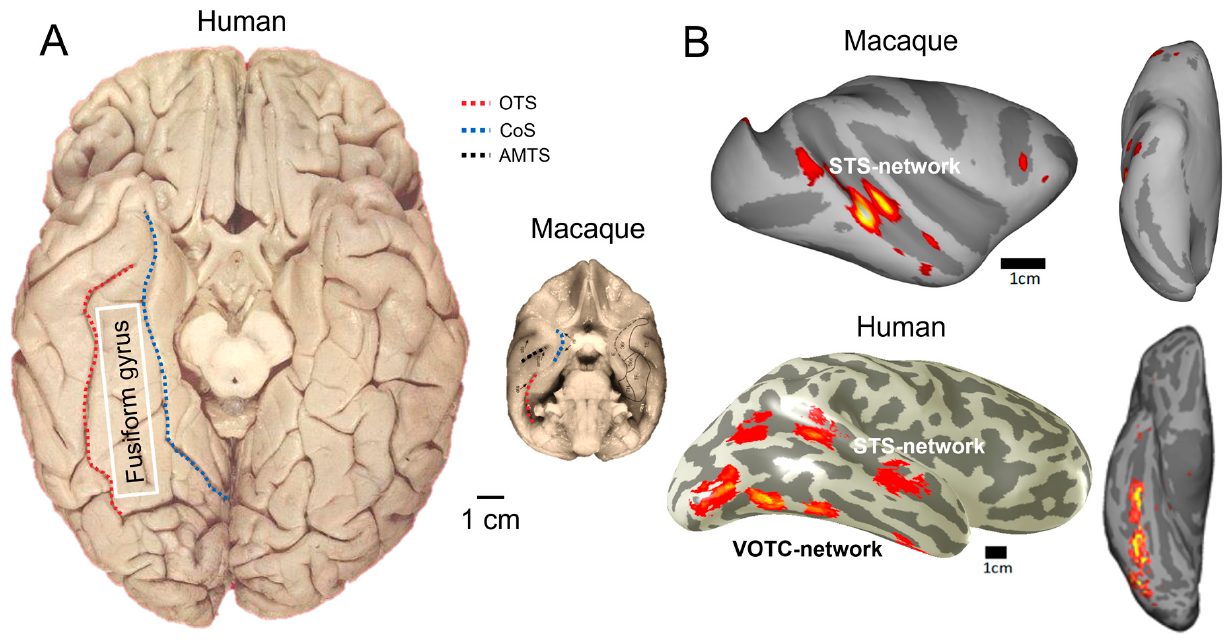
Figure 9. Human specificity of neural circuits for face identity recognition. ( A ) Ventral view of a human and a macaque brain at relative sizes. The human brain contains an estimated number of 86 billion neurons, about 13.5 times more than a macaque brain (6.3 billion) [143]) In humans, the key neural structures for face identity recognition run from the lateral section of the inferior occipital gyrus to the posterior, middle lateral and anterior fusiform gyrus (FG) up to the temporal pole. In comparison, the posterior ventral occipito-temporal cortex of the macaque brain is limited to one sulcus, with little gyrification and no fusiform gyrus [147]. ( B ) Inflated segmented brains showing typical locations of posterior face-selective regions (colored spots) in macaques and humans (adapted from [103]; with permission under a PMC Creative Commons License). In macaques, these regions are essentially found in the STS, whereas humans have face-selective regions in both the STS and the VOTC.